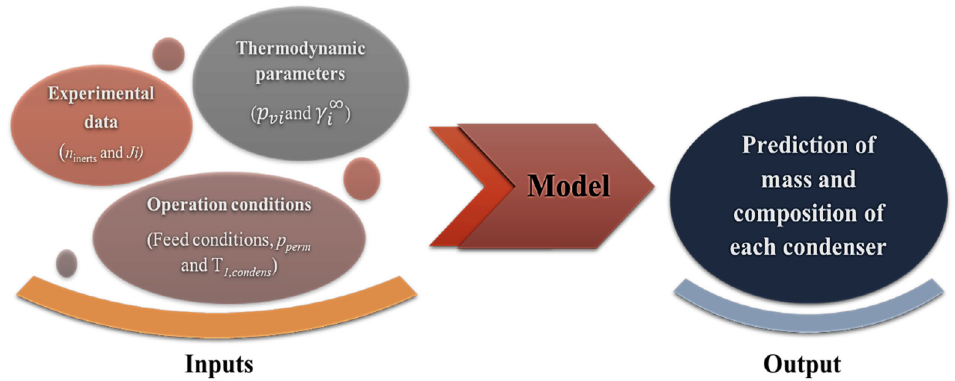
Figure 4. Diagram representing the flux of data in this work.